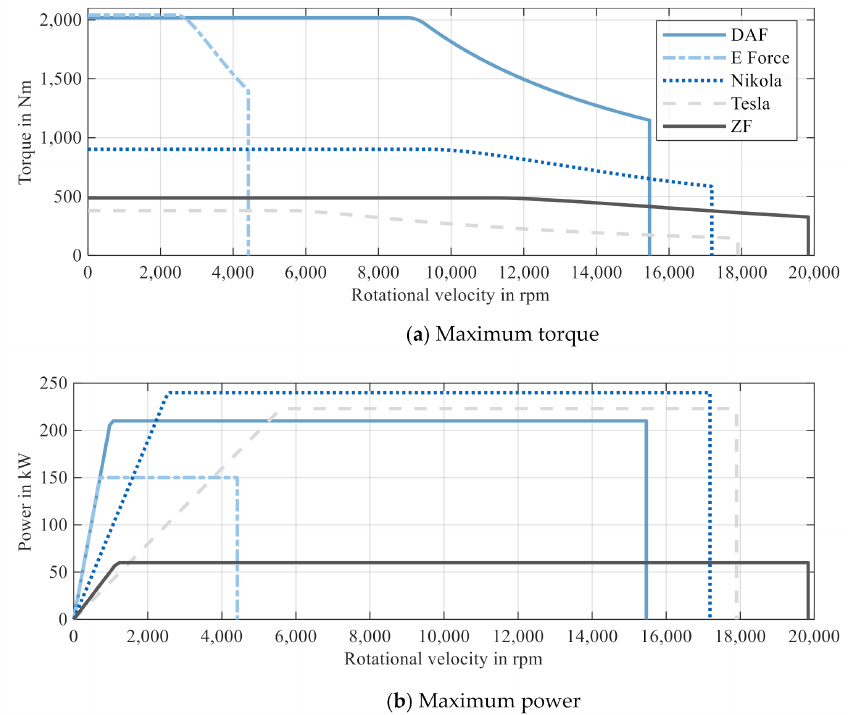
Figure 3. Curves of the maximum motor torque ( a ) and the power ( b ), measured at the output of the electrical machines. The maximum power is limited to the rated power due to technical restriction of the maximum possible current (500 A).